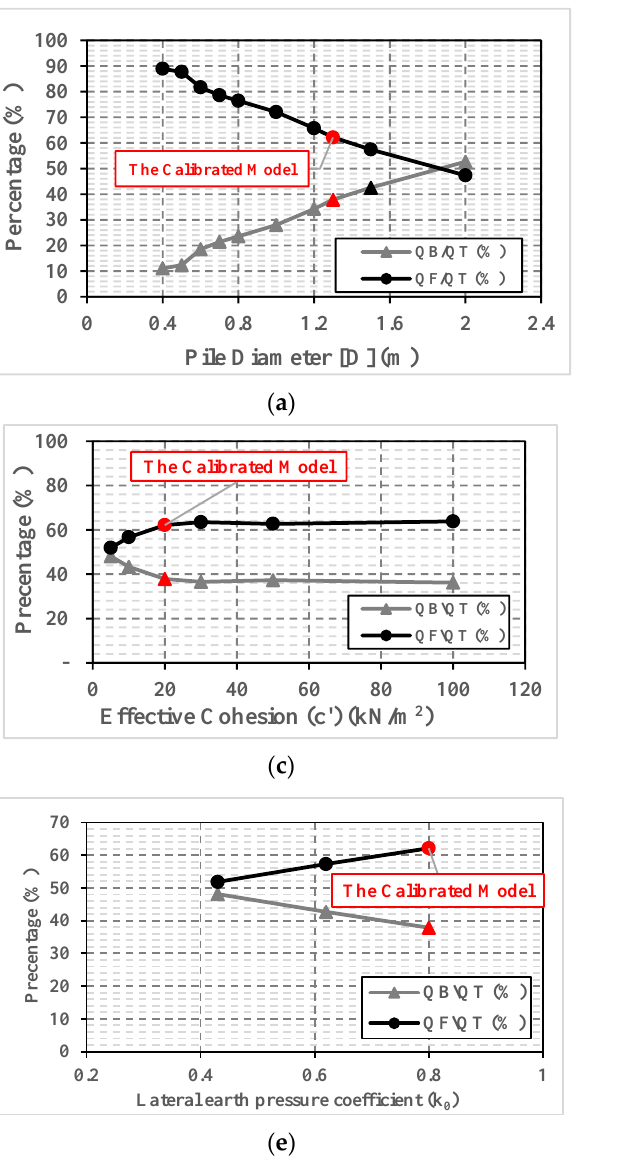
Figure 5. Variation of the ultimate bearing (Q b ), friction (Q f ), and total capacities (Q t ) with the different parameters. ( a ) Pile diameter (D). ( b ) Pile length (L). ( c ) Soil effective cohesion (c’). ( d ) Effective friction angle (Ø’). ( e ) Lateral earth pressure coefficient (K 0 ). ( f ) Young’s modulus (E s ). ( g ) Soil dilatancy ( Ψ ).